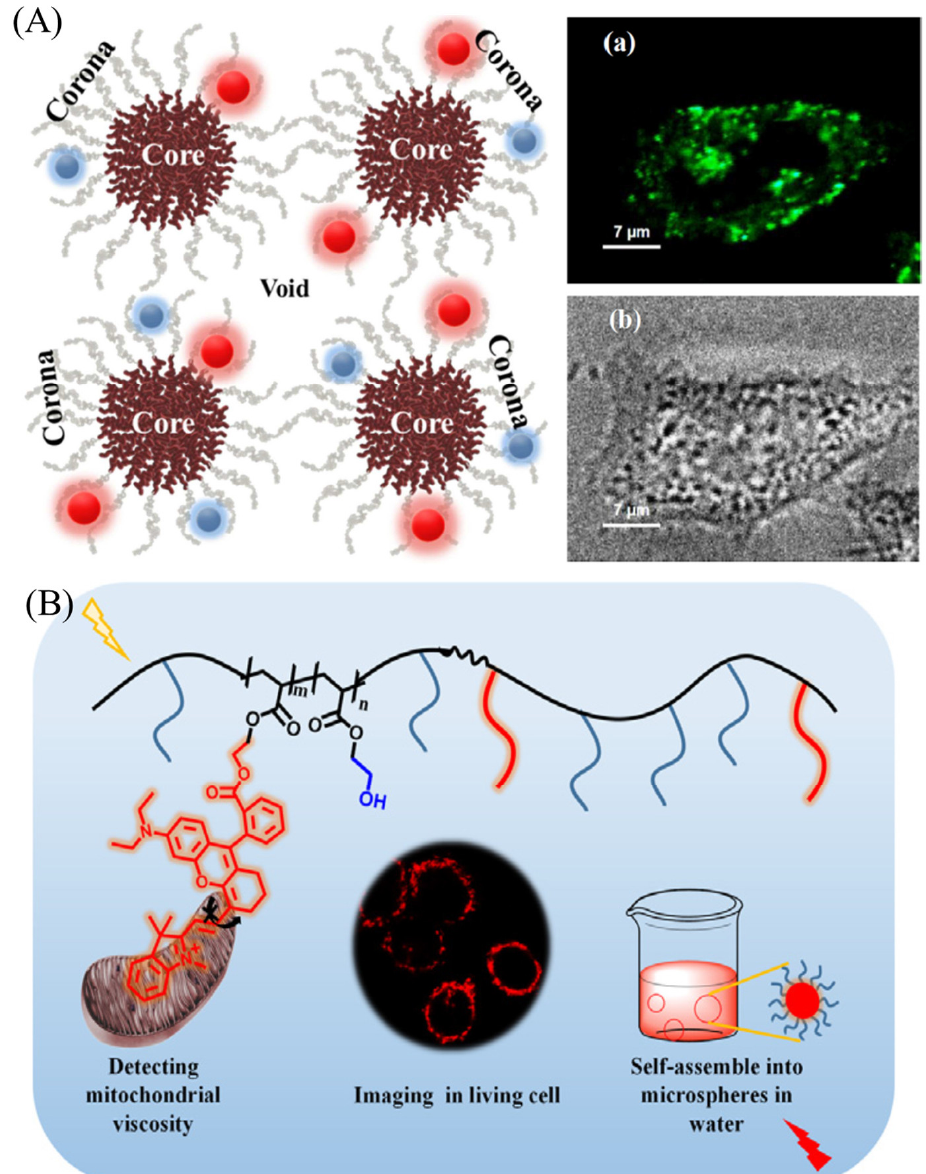
Figure 4. ( A ) Schematic figure of a triblock copolymer Pluronic F127 and the fluorescent images in